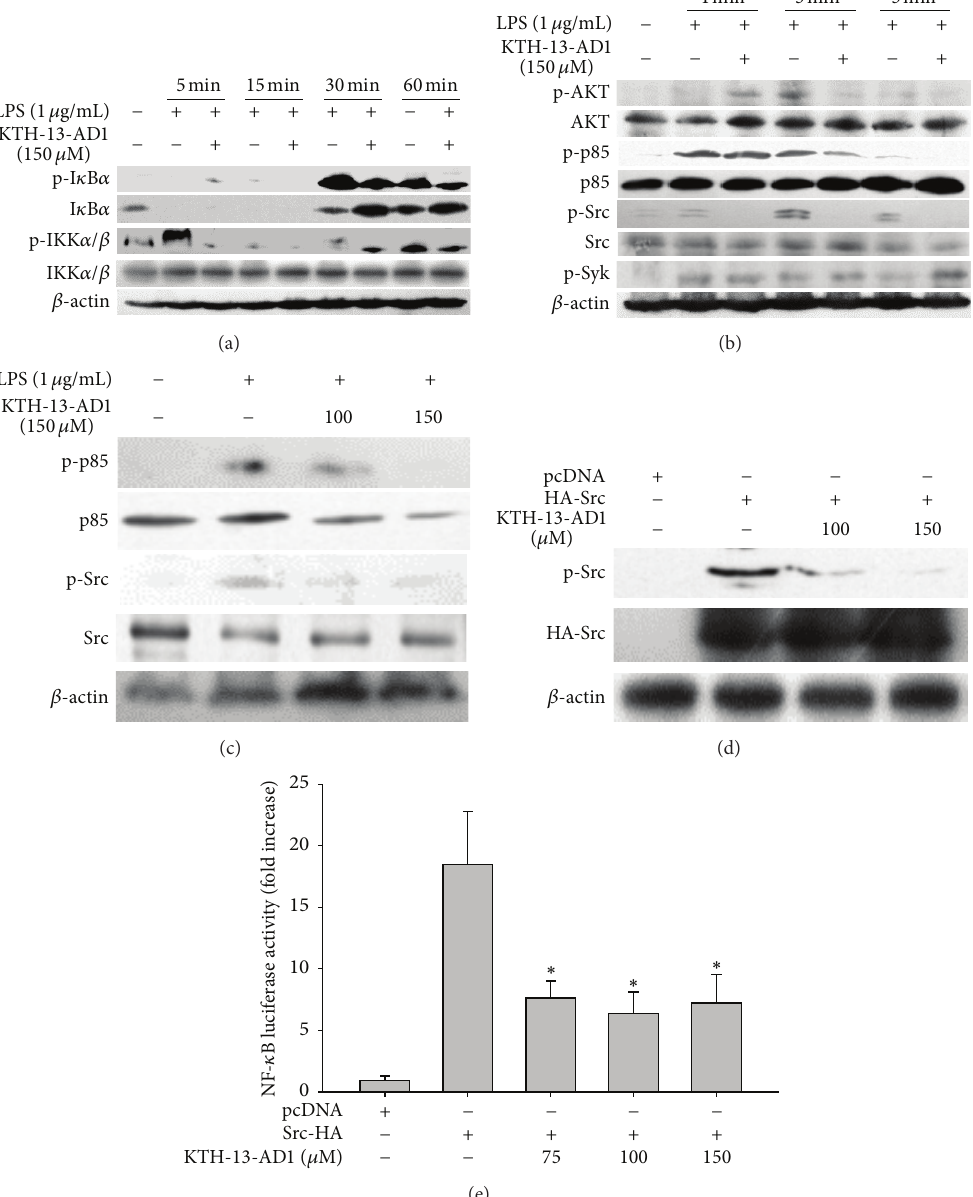
Figure 3: Effect of KTH-13-AD1 on the activation of upstream signaling cascades of NF- 𝜅 B. (a, b, c) Phospho- and total protein levels of I 𝜅 B 𝛼 , IKK 𝛼 / 𝛽 , AKT, p85, Src, Syk, and 𝛽 -actin from cell lysates were determined through immunoblotting analysis. (d) The inhibitory activity of KTH-13-AD1 on the phosphorylation of p85 and Src, triggered by HA-Src overexpression in HEK293 cells, was evaluated using immunoblotting analysis. (e) NF- 𝜅 B-mediated luciferase activity triggered by HA-Src overexpression in HEK293 cells, either in the presence or absence of KTH-13-AD1, was evaluated using luminometric analysis. ∗ 𝑃 < 0.05 compared to the vehicle